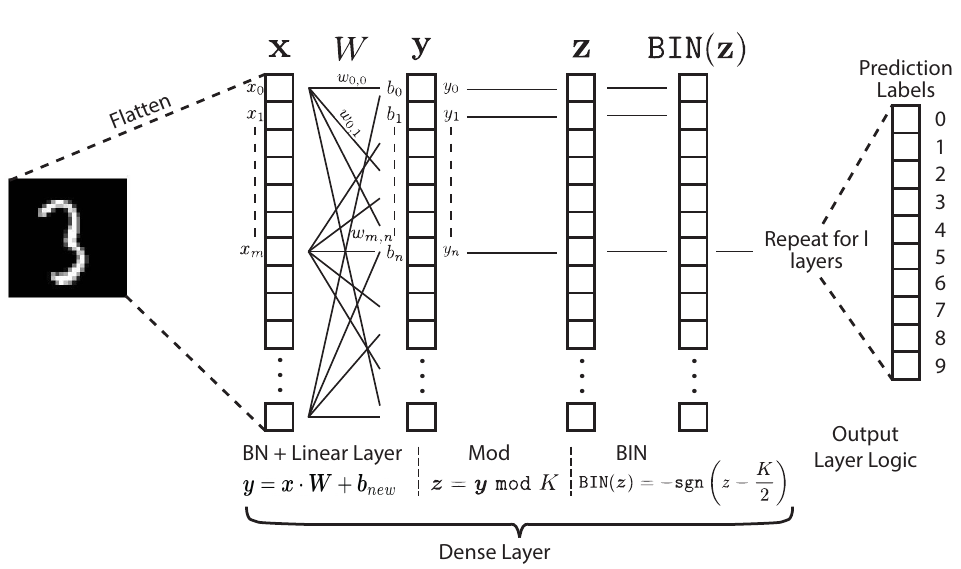
Figure 4: ModuloNET dense layer architecture for inference. The output of the last layer is processed using a more complex logic given by Algorithm